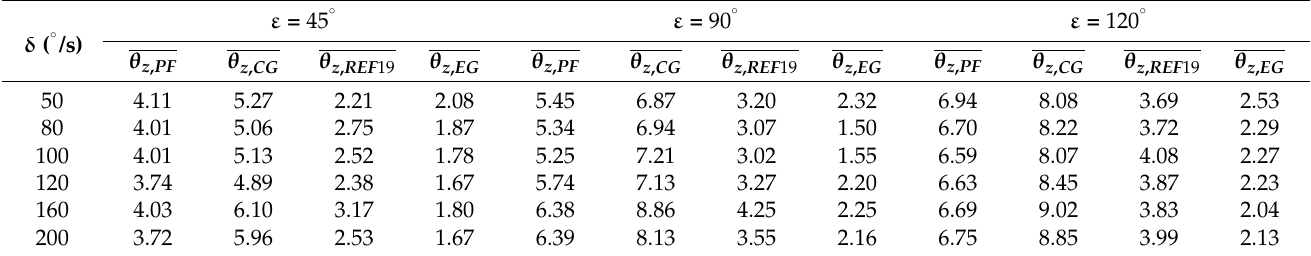
Table 1. Average tilt angles θ z under 18 vibration conditions ( ◦ ).